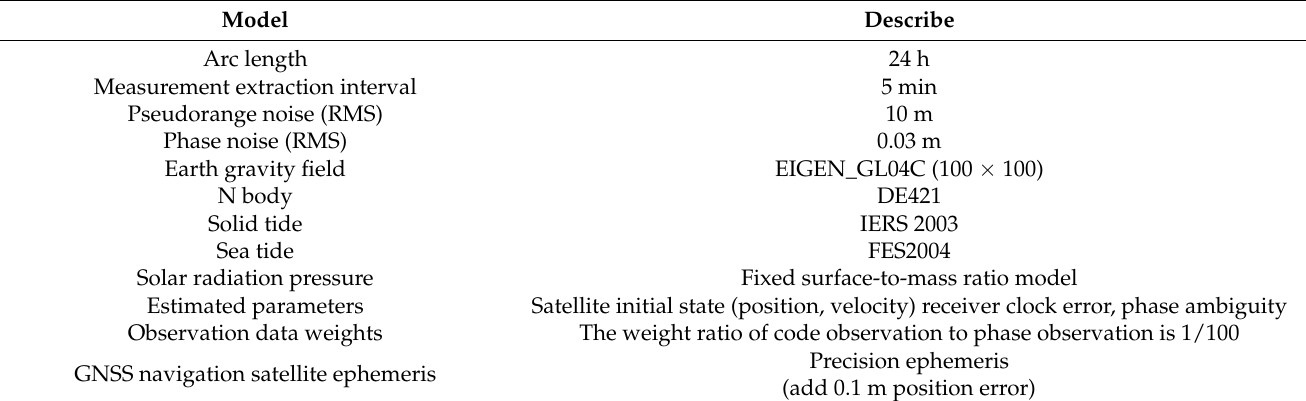
Table 4. Processing strategy for POD.